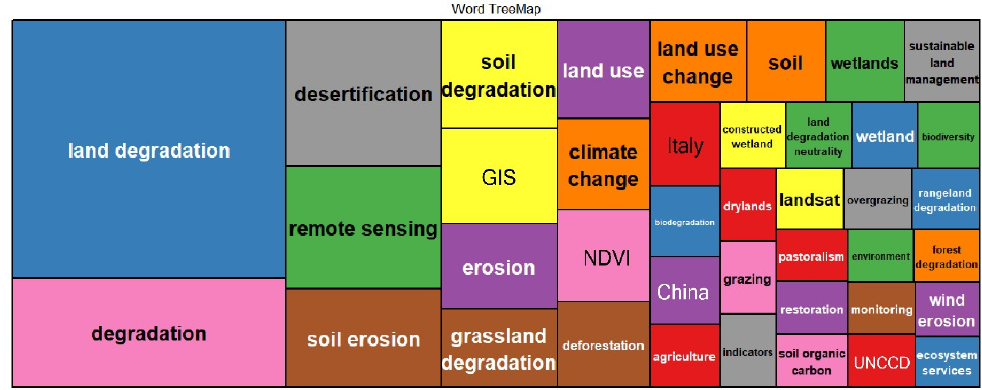
Figure 10. Word TreeMap of high-frequency keywords in the field of land degradation.